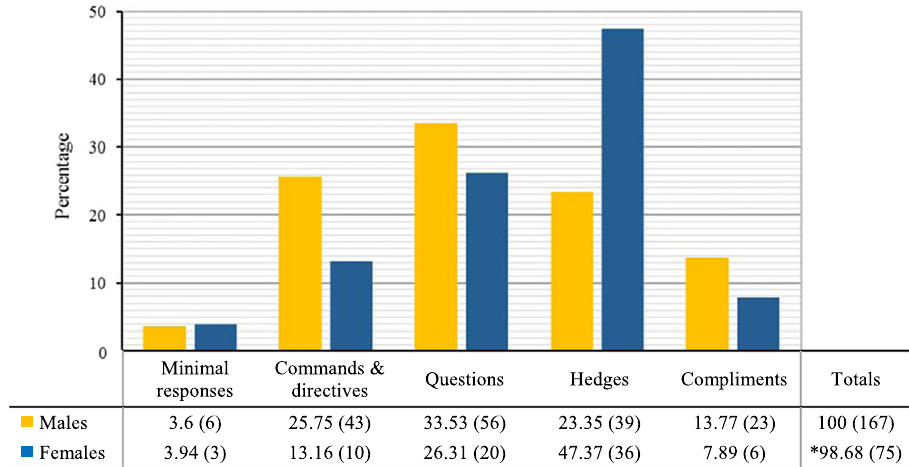
Fig. 2 Distribution of conversational strategies in Mulan-2 ( N = 243). *Total does not equal 100% because there was one tag-question for